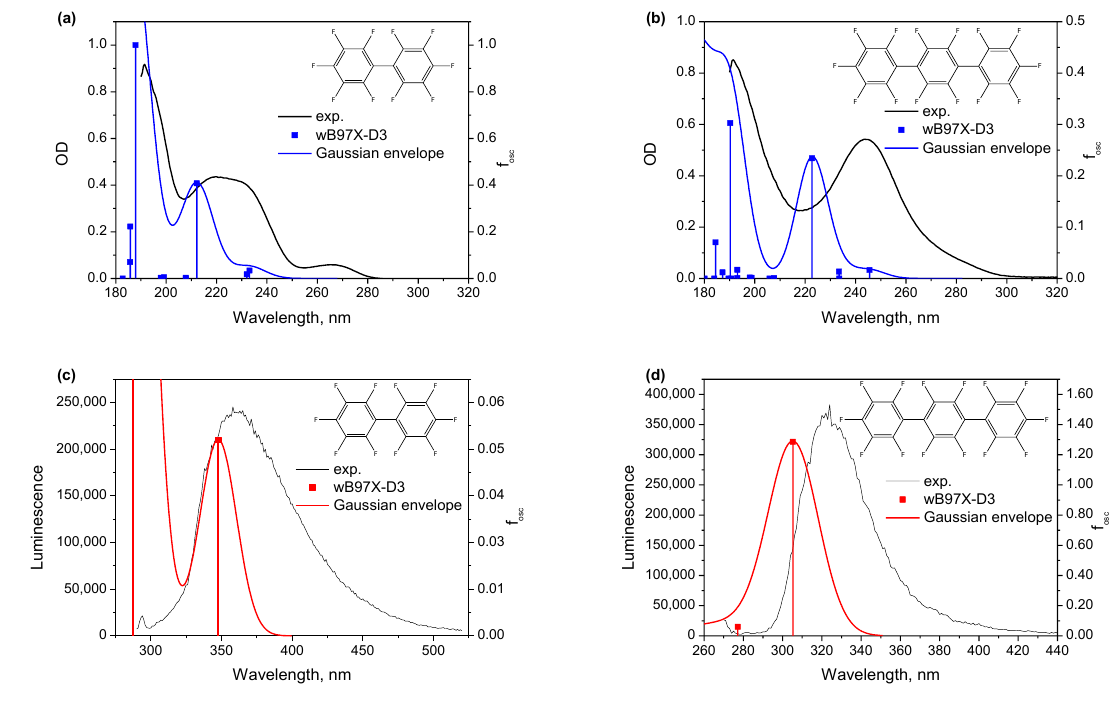
Figure 6. Calculated absorption lines for equilibrium structures of 1 ( a ) and 2 ( b ) in heptane (square points) and the corresponding experimental absorption spectra from Figure 1, and calculated ab- sorption lines for equilibrium structures of 1 * ( c ) and 2 * ( d ) in heptane (square points) and the corresponding experimental luminescence spectra from Figure 2.